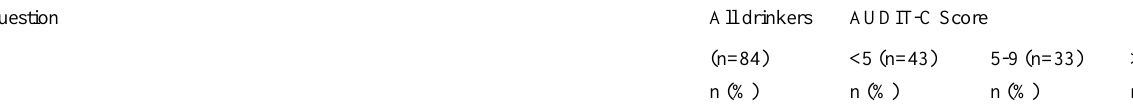
AUDIT-C ScoreAll